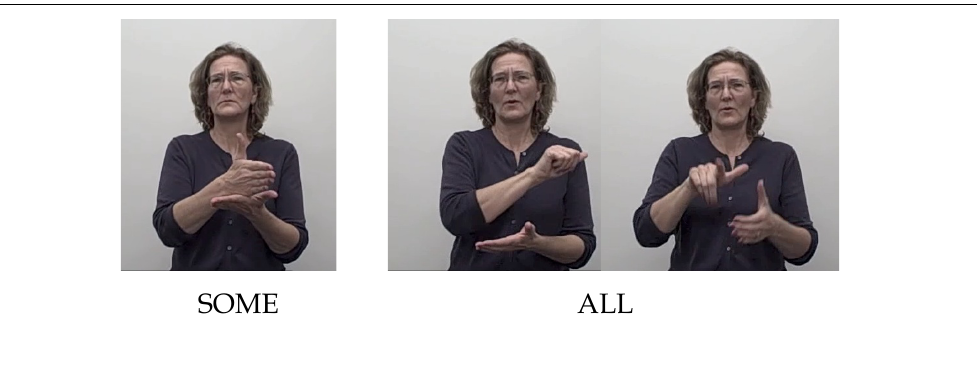
some and all used in the Quantifier sentence